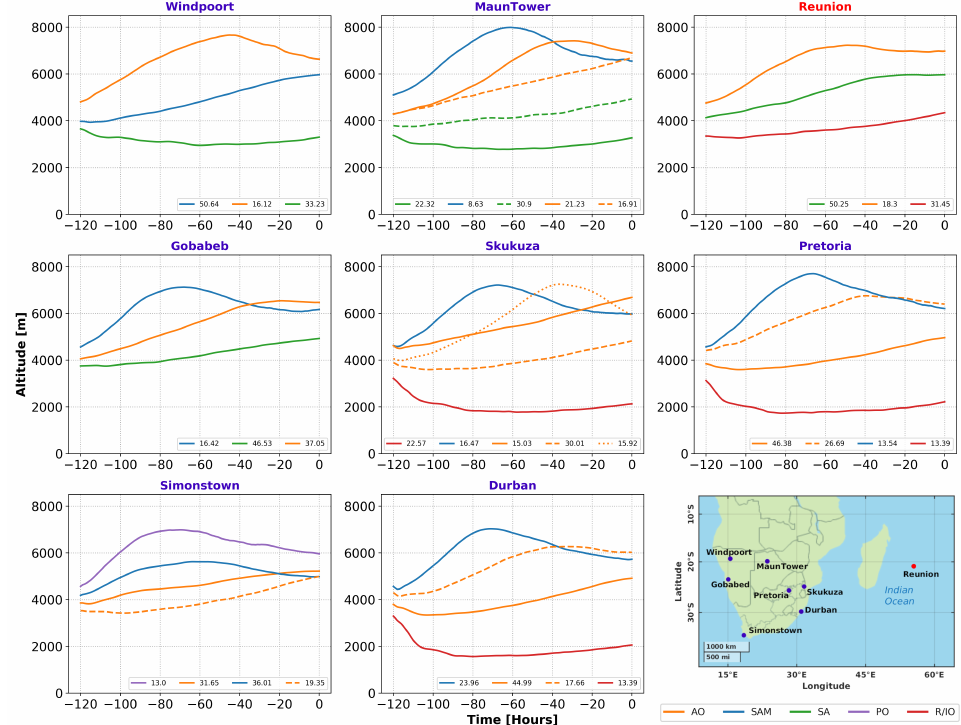
Figure A3. Height level of each back-trajectory cluster over the eight sun photometer sites. Each color is associated with a location: orange for Atlantic Ocean (AO), blue for South America (SAM), green for South Africa (SA), purple for Pacific Ocean (PO), and red for recirculation and Indian Ocean